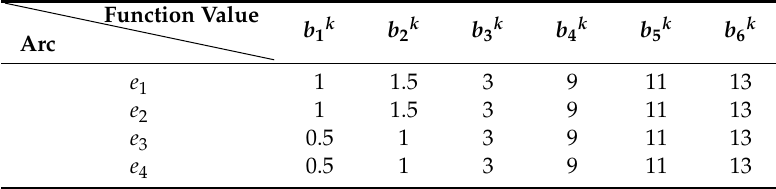
Table 6. Fuzzy function value of flow and time for each arc.